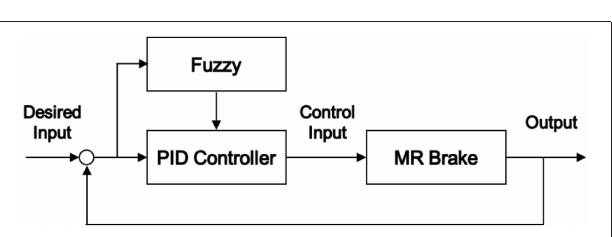
FIGURE 9 | Block diagram of the fuzzy-PID control